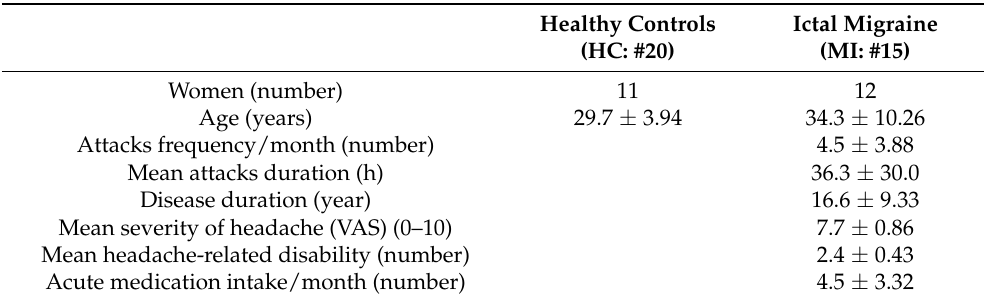
Table 1. Clinical and demographic data of healthy controls (HC) and patients with migraine ictus